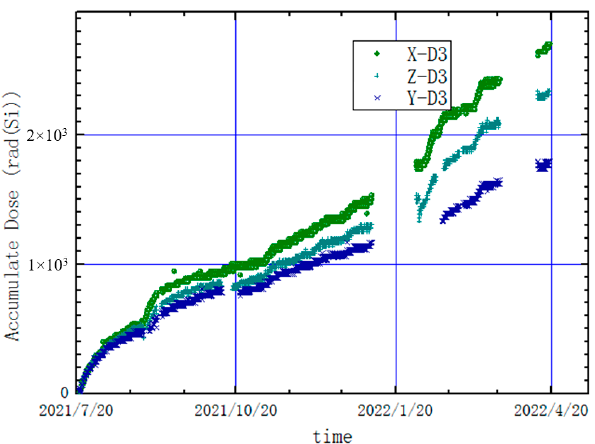
Figure 10. Cumulative dose results of the three dose detectors at monitoring point D3.